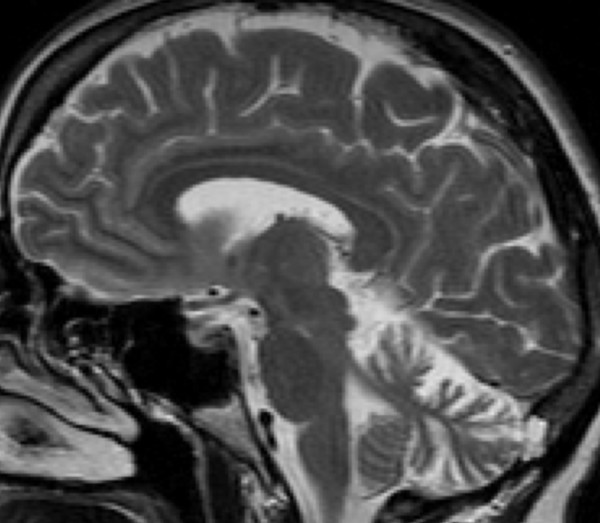
MRI brain of patient 2 showing atrophy of cerebellum.